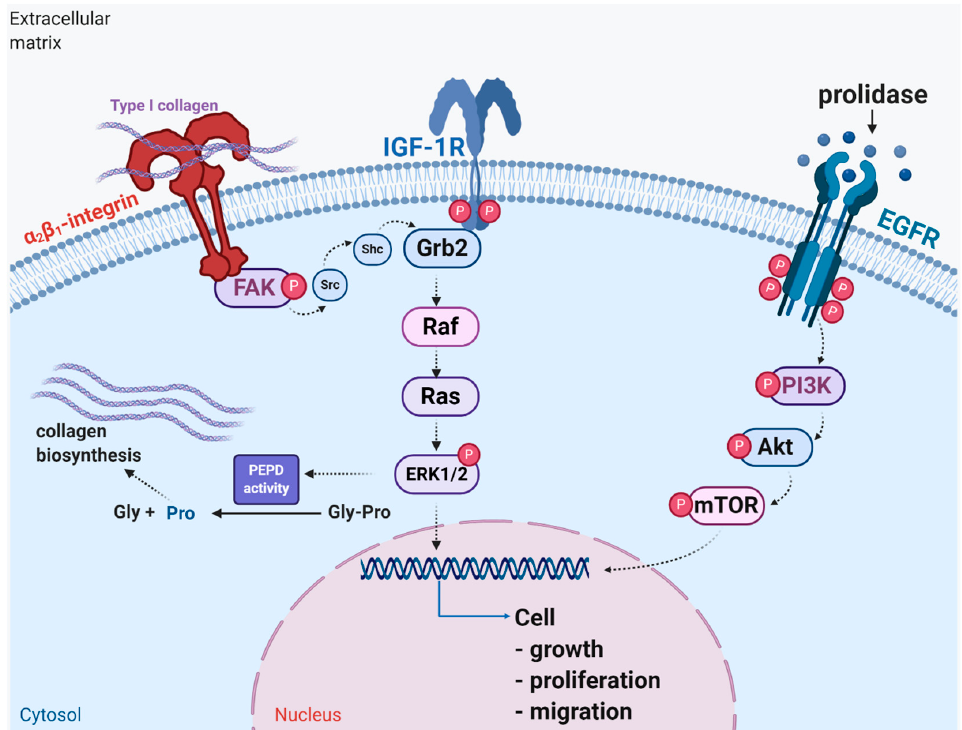
Figure 6. Schematic representation of the functional significance of activation of EGFR, IGF-1R, and β 1 -integrin receptor downstream signaling in wound healing. Under experimental conditions of mechanically “wounded” fibroblasts, PEPD activates EGFR-dependent downstream PI3K/Akt/mTOR signaling, while IGF-1R and β 1 -integrin receptor cooperate to activate MAPK (ERK1/2) pathway resulting in increased cell proliferation, migration and collagen biosynthesis. Created with BioRender.com.